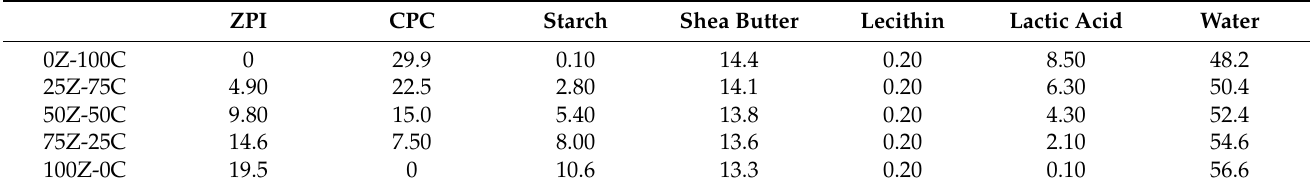
Table 1. Formulation (%) of the cheese alternative